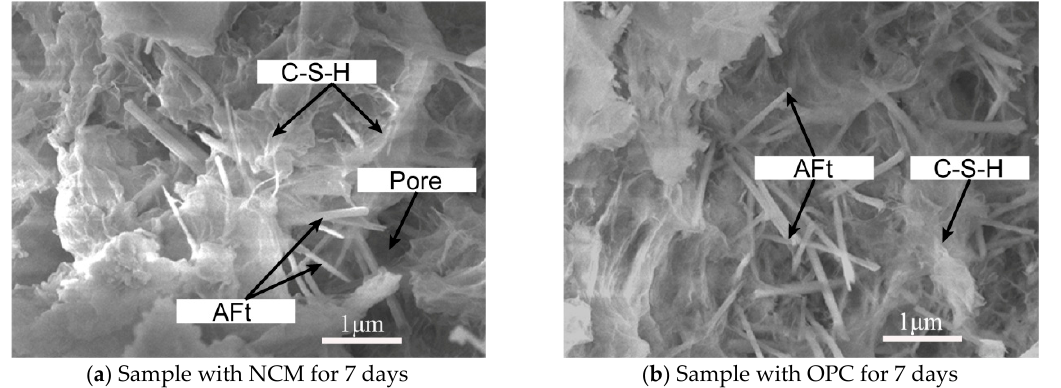
Figure 10. SEM images of samples with NCM and OPC for 3 days of curing time.